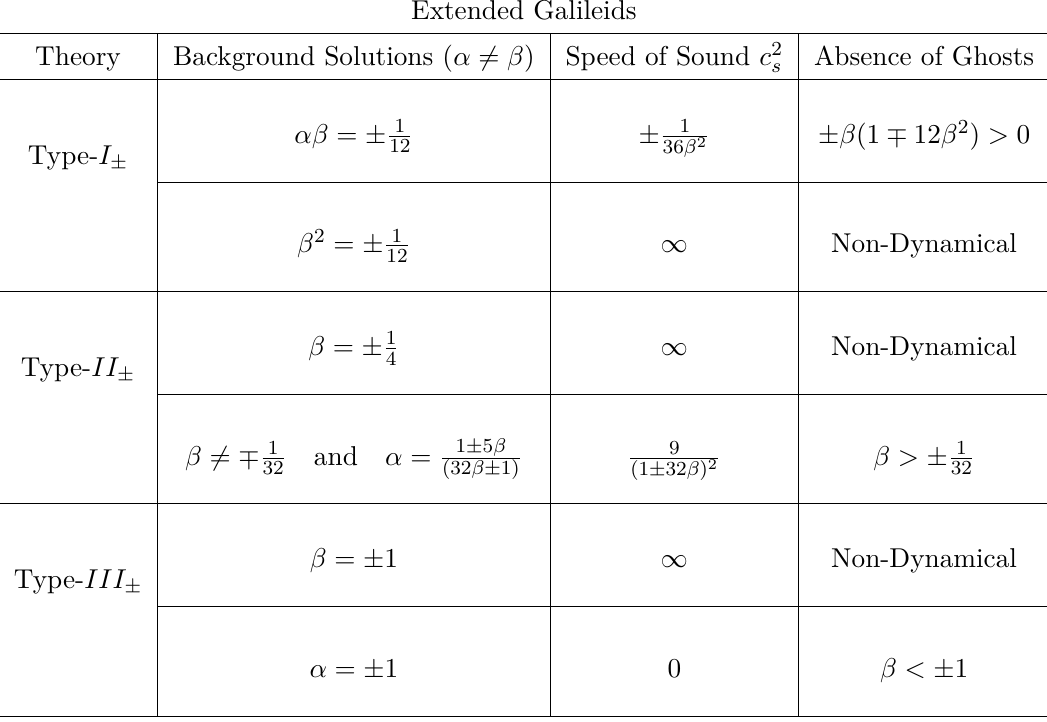
Dynamics of extended galileid phonons around the background solution h φ ( x ) i = (cid:0) (cid:1) 1 β | x | 2 − αt 2 with α 6 = β . We show the speed of progagation of the phonons c 2 2